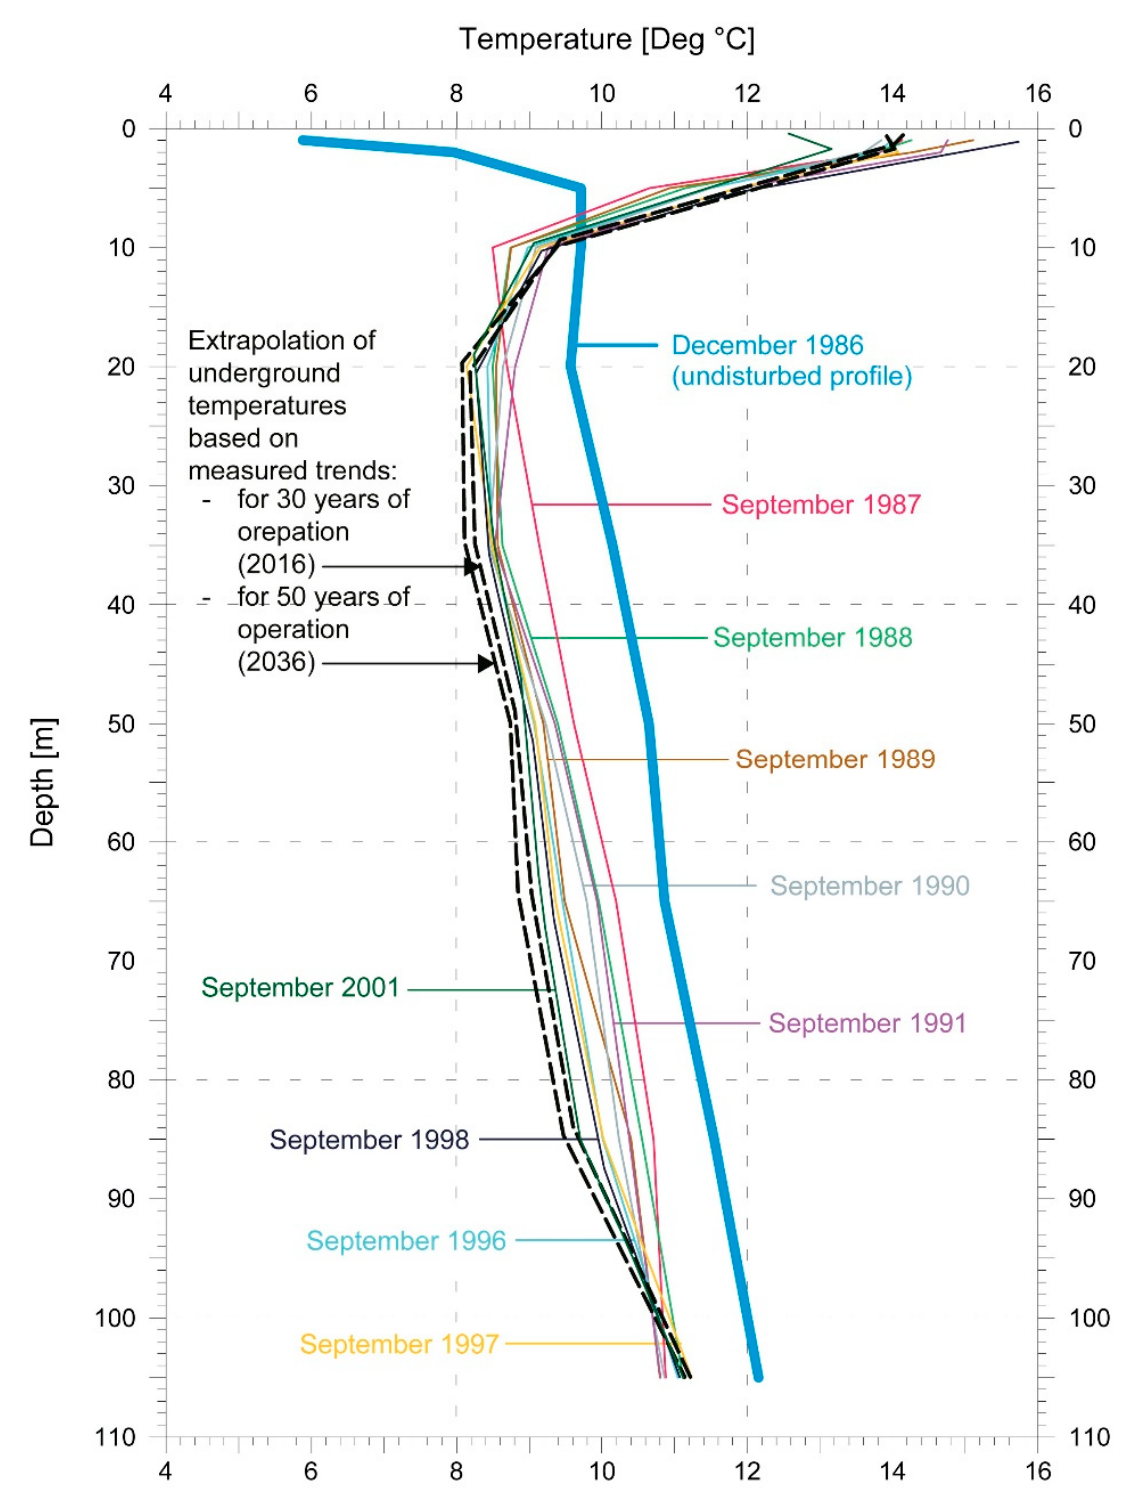
Figure 7. Further modeled temperature profiles (at a distance of 0.5 m from the BHE in Elgg), in addition to the measured profiles in the first and second campaigns; for the autumns of 2001, 2016, and 2036. Data from [8] are plotted. For details, see text.